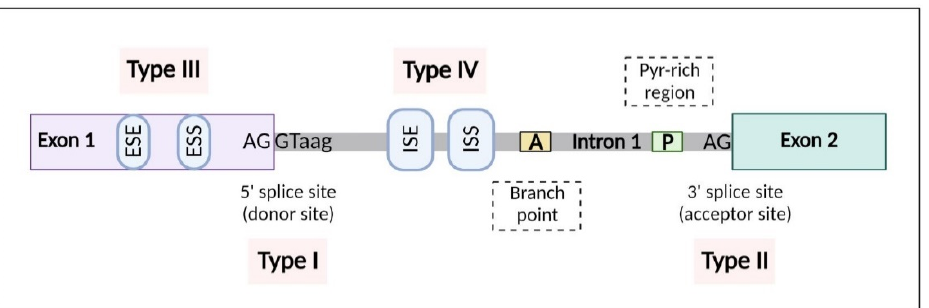
Figure 1. Schematic representation of the splicing sequences that can be altered by mutations and their classification for this review. The DNA sequences include donor and acceptor splice sites (Type I and Type II, respectively); exonic sequences, including exonic splicing silencers (ESS) and enhancers (ESE) (Type III); and intronic sequences, including intronic splicing enhancers (ISE) and silencers (ISS) (Type IV).